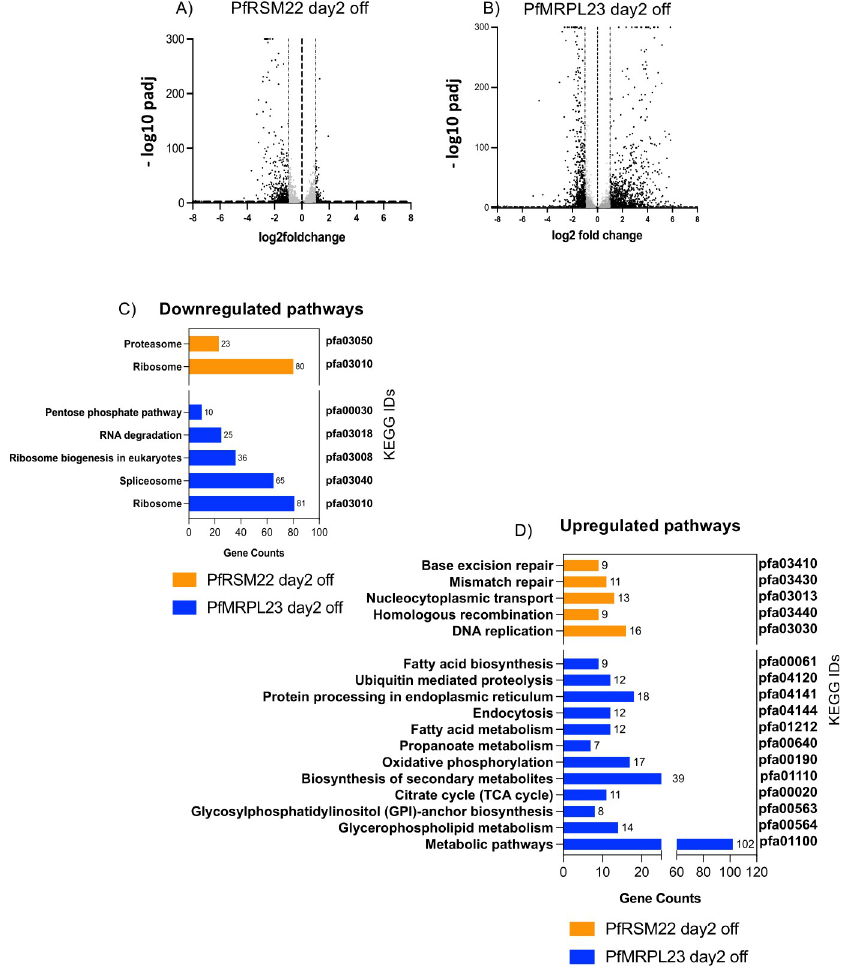
Fig 4. Transcriptomic changes in the early phase after KD of PfRSM22 and PfMRPL23. Volcano plots of differentially regulated transcripts (p adj < 0.05) on day 2 post KD in the PfRSM22 KD line (A) and in the PfMRPL23 line (B). Each black dot in the Volcano plots represents a gene regulated at least by 2-fold (log2 fold � 1 and � -1). Each grey dot indicates a gene differentially regulated less than 2-fold (log2 fold < 1 and > -1). (C) Significantly downregulated KEGG functional pathways based on the number of genes (gene counts) following the KD of PfRSM22 or PfMRPL23 on day 2. (D) Significantly upregulated KEGG functional pathways based on the number of genes (gene counts) following the KD of PfRSM22 or PfMRPL23 on day